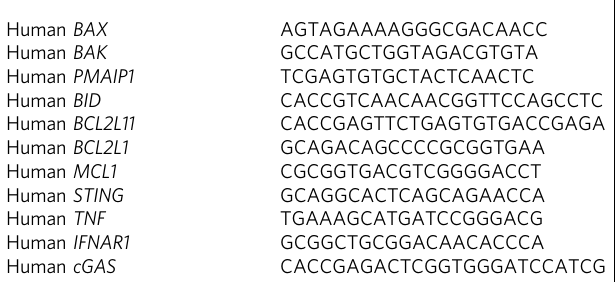
Table 1 Guide sequences used in CRISPR-Cas9-based generation of KO cell lines.